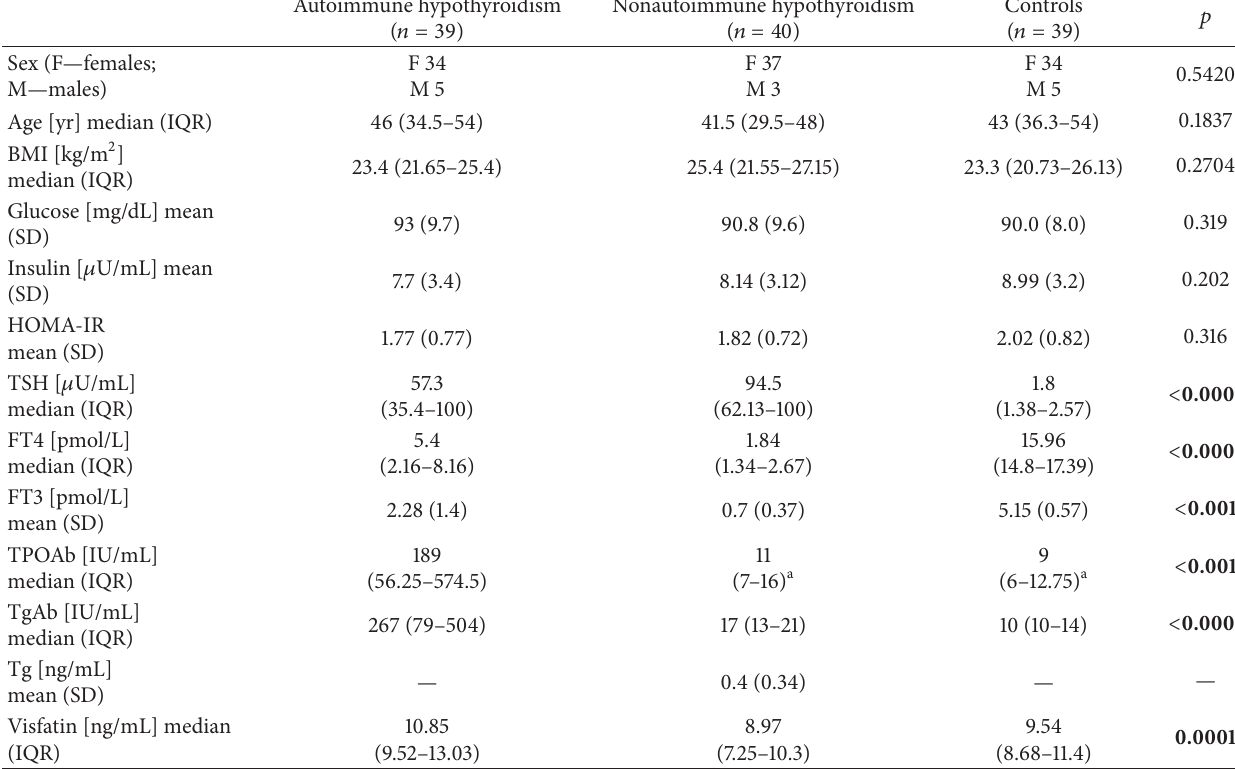
Table 1: Comparison of clinical and laboratory characteristics between the study groups and controls.